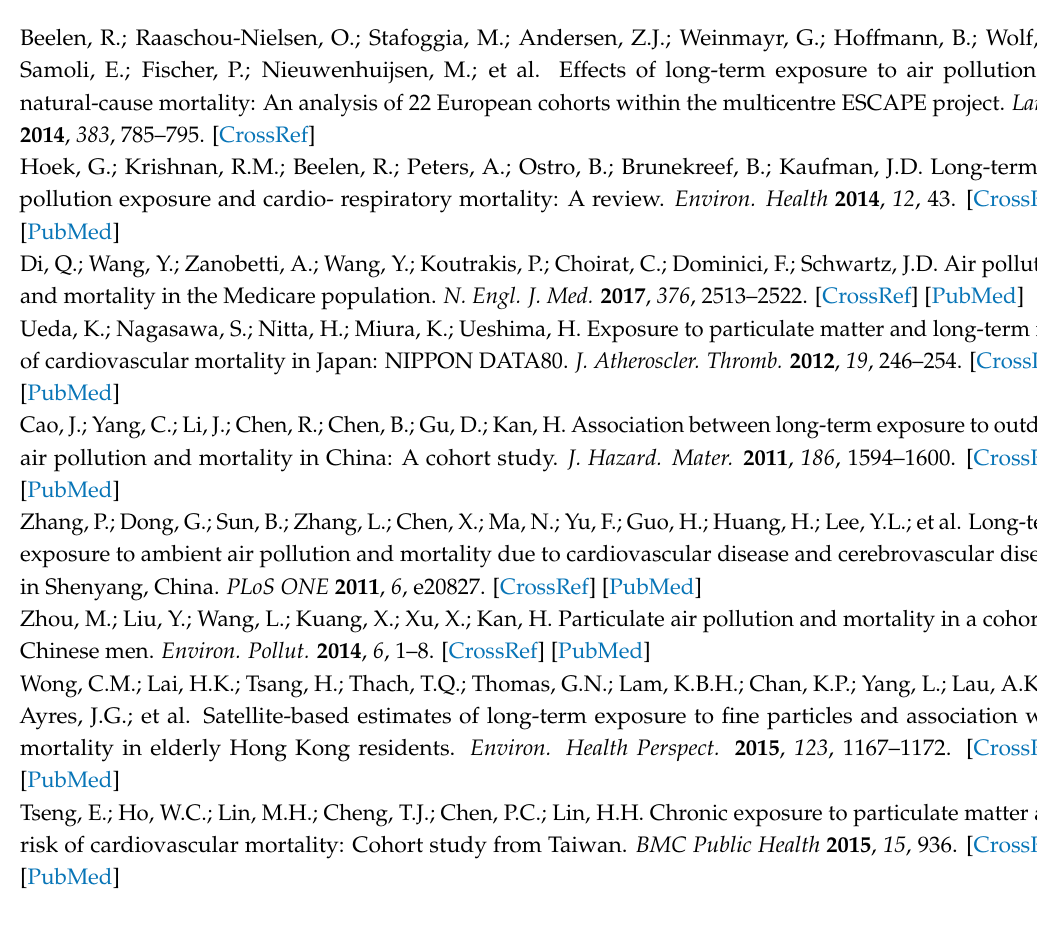
Figure S1: Schematic diagram of exclusion criteria and numbers of National Health Insurance Service- National Sample Cohort subjects included or excluded after the application of each criterion, Figure S2: Maps of predicted district-specific annual concentrations of PM 10 in 2010, South Korea, Table S1: Definition of four exposure assessment (EA) approaches, Equations for individual-level 5-year PM 10 average concentrations by the four different exposure assessment (EA) approaches, Table S2: Descriptive statistics and correlation coefficients of long-term PM 10 concentrations of 275,337 National Health Insurance Service- National Sample Cohort (NHIS-NSC) subjects across four exposure assessment (EA) approaches, Table S3: Adjusted hazard ratios (HRs) and 95% confidence intervals (CIs) of non-accidental and cause-specific mortality for an increase of 10 µ g/m 3 in the long-term concentration to PM 10 defined by four different exposure assessment (EA) approaches, Table S4: Adjusted hazard ratios (HRs) and 95% confidence intervals (CIs) of mortality for an increase of 10 µ g/m 3 in 12-year average PM 10 concentrations in 275,337 National Health Insurance Service-National Sample Cohort (NHIS-NSC) subjects for 2002–2013 in South Korea, Table S5: Adjusted hazard ratios (HRs) and 95% confidence intervals (CIs) of mortality for an increase of 10 µ g/m 3 in measurement-based long-term PM 10 concentrations in 237,224 National Health Insurance Service- National Sample Cohort (NHIS-NSC) subjects for 2002–2013 in South Korea, Table S6: Adjusted hazard ratios (HRs) and 95% confidence intervals (CIs) of mortality for an increase of 10 µ g/m 3 in the long-term PM 10 concentrations from time-dependent Cox proportional hazards models, Table S7: Adjusted hazard ratio (HRs) and 95% confidence interval (CIs) of mortality for an increase of 10 µ g/m 3 in the long-term PM 10 concentrations from Cox proportional hazards model incorporating random effects for subjects’ residential districts at baseline, Table S8: Summaries of previous cohort studies of the association between long-term exposure to PM 10 and